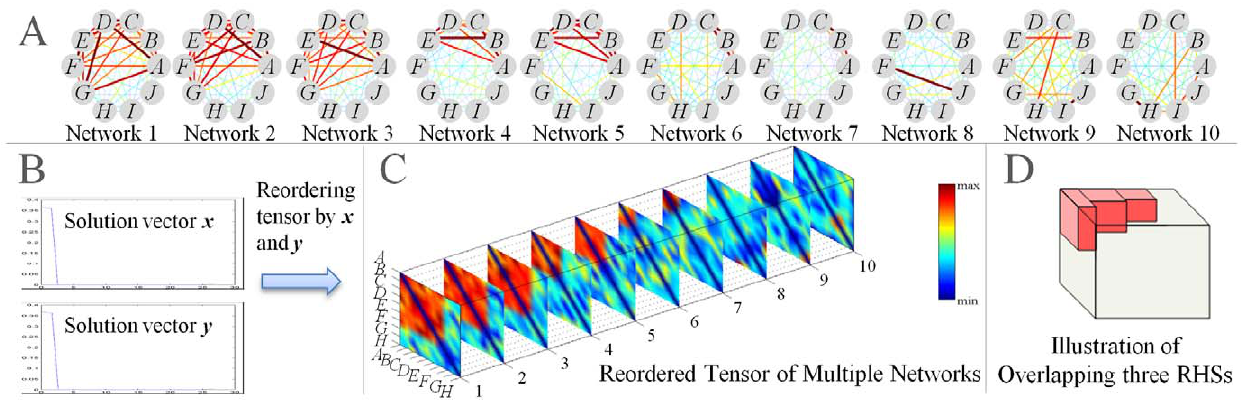
Figure 2. Illustration of an RHS family and its tower-like structure in ^ xx and ^ yy . ( A ) Ten networks of 10 genes {A,B,C,D,E,F,G,H,I,J}, where the edge weight is associated with the color scale shown in ( C ); ( B ) The optimal membership vectors ^ xx and ^ yy obtained by performing MSCR. Their significant components are ranked as follows: x A § x B § x C § x D § x E § x F w 0 , and y 1 § y 2 § y 3 § y 4 § y 5 § y 6 § y 7 ; ( C ) The tensor of networks and genes arranged in decreasing order of the elements in ^ xx and ^ yy . Three RHSs are discovered: the first RHS recurs in networks {1,2,3,4,5,6,7} with member genes {A,B,C}; the second recurs in networks {1,2,3,4,5} with member genes {A,B,C,D,E}; and the third recurs in networks {1,2,3} with member genes {A,B,C,D,E,F,G}; ( D ) A more intuitive illustration of three three overlapping RHSs, which form a tower-like